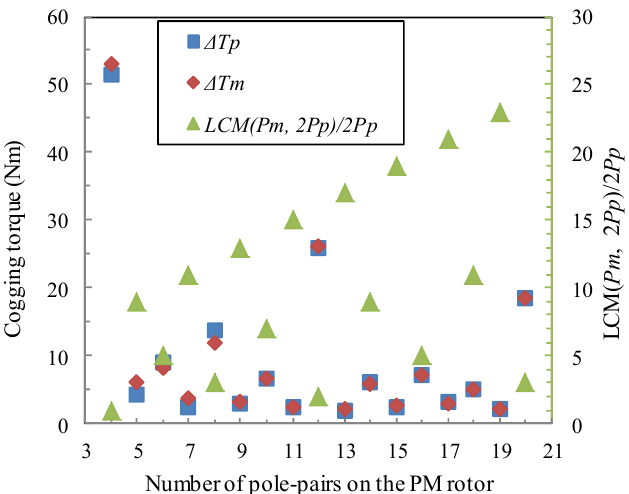
Figure 13. Variation of cogging torque and the PM rotor.